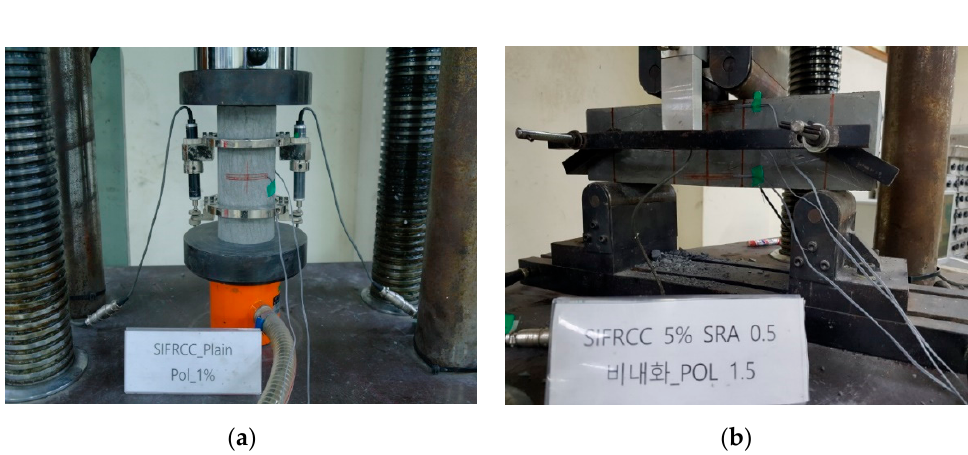
Figure 3. Experimental set up for the specimen before high temperature exposure: ( a ) Experimental set up for the compressive strength test before high temperature exposure; and, ( b ) Experimental set up for the bending test with third point loading before high temperature exposure.